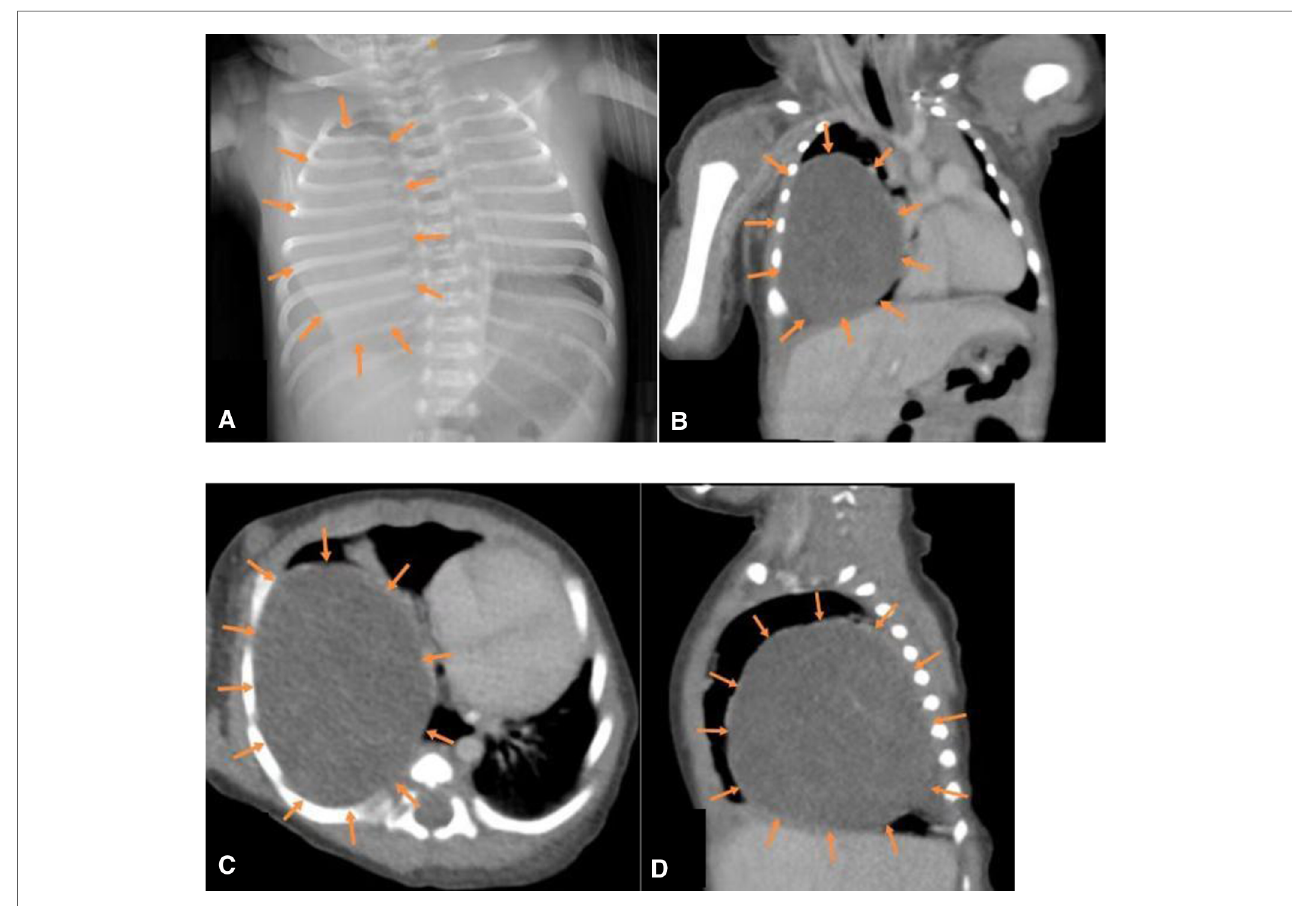
FIGURE 2 ( A ) x-ray and ( B – D ) CT (coronal, transverse and sagittal sections) showing a large mass in the right lower lobe.